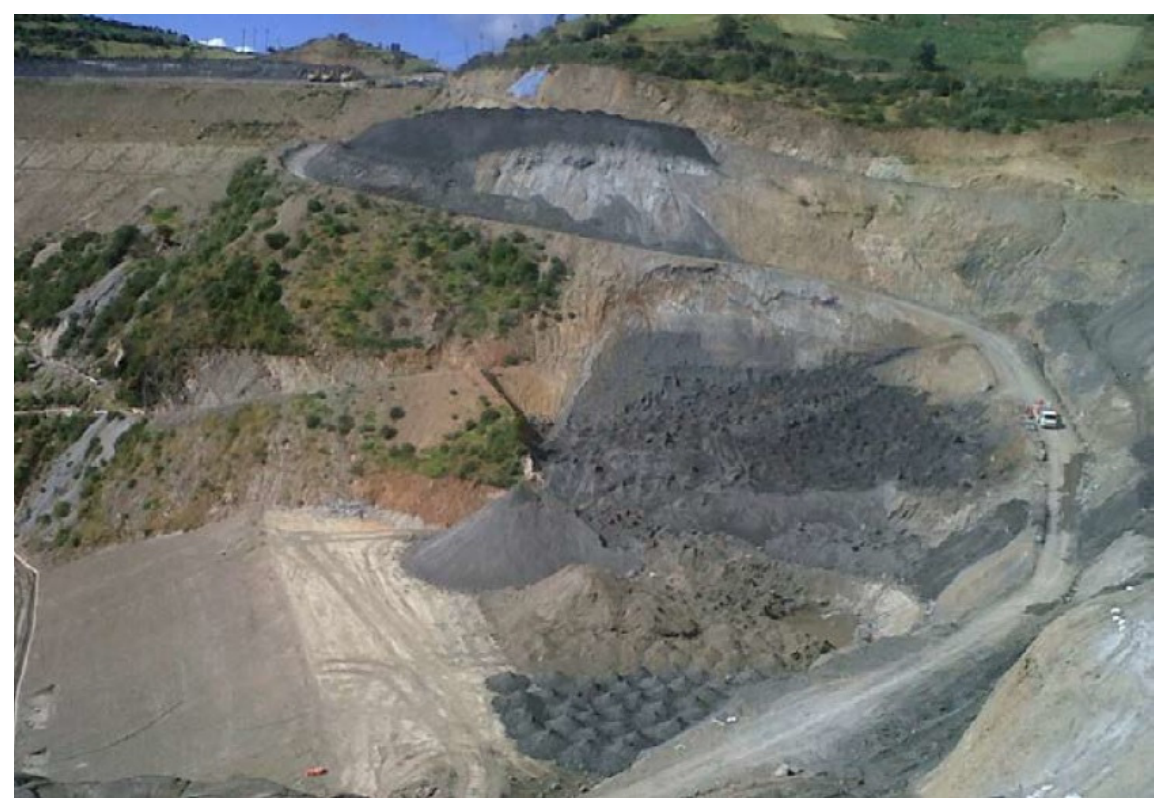
Figure 69. Ramahuayco TSF Overview [40,41].